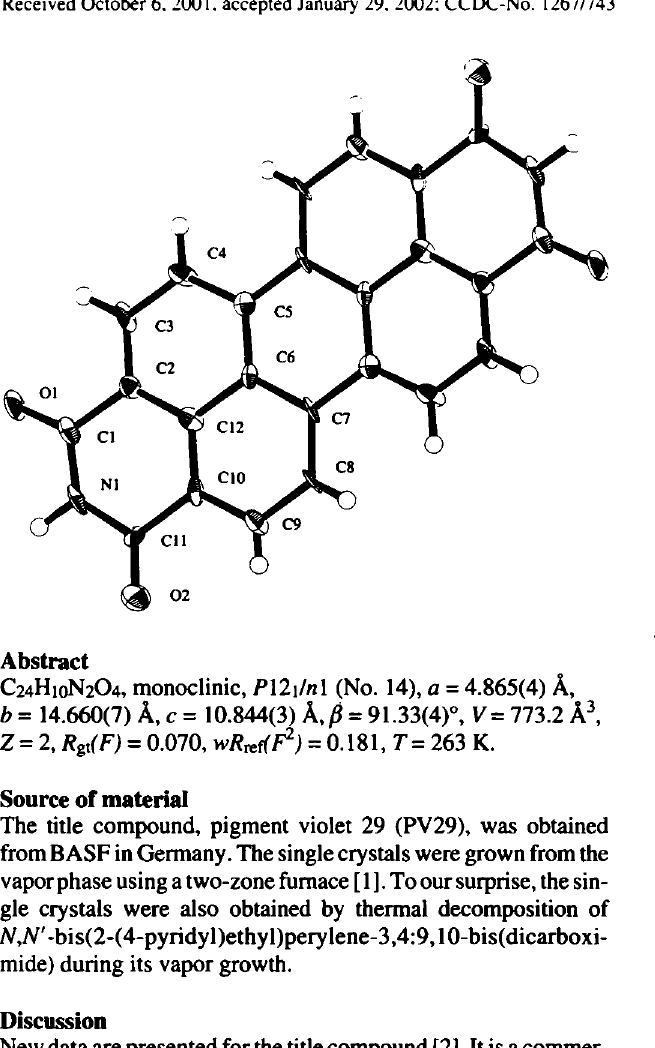
Table 2. Atomic coordinates and displacement parameters (in Â 2